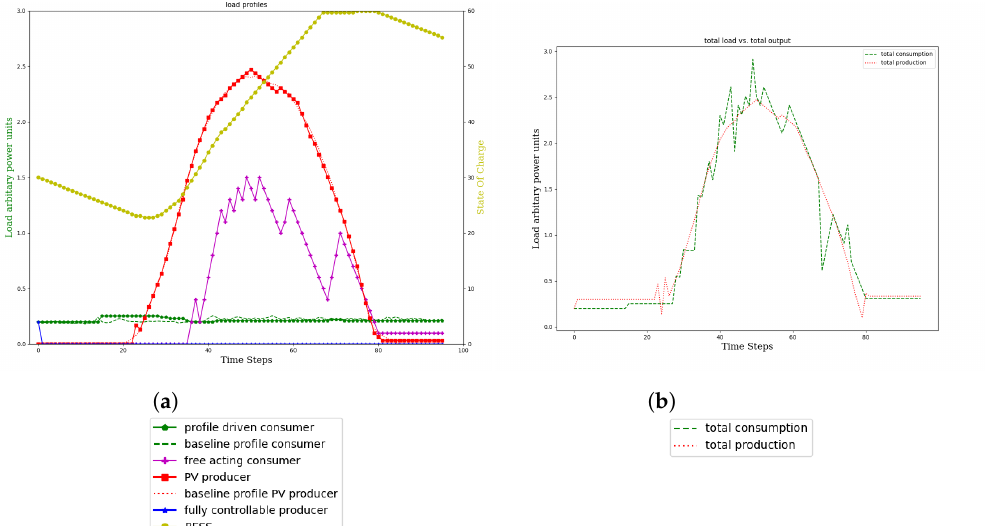
Figure 16. Evaluation on day 3, with the generalised trained agents. ( a ) Agent load curves and profiles. ( b ) Load